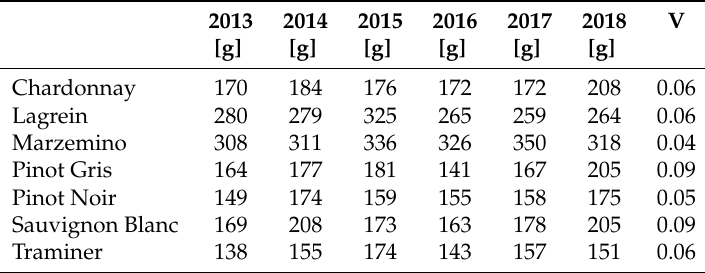
Table 1. Average cluster weight in grams for different grape varieties in Trentino (Italy) for the five years between 2013 and 2018, with the overall relative deviation V.